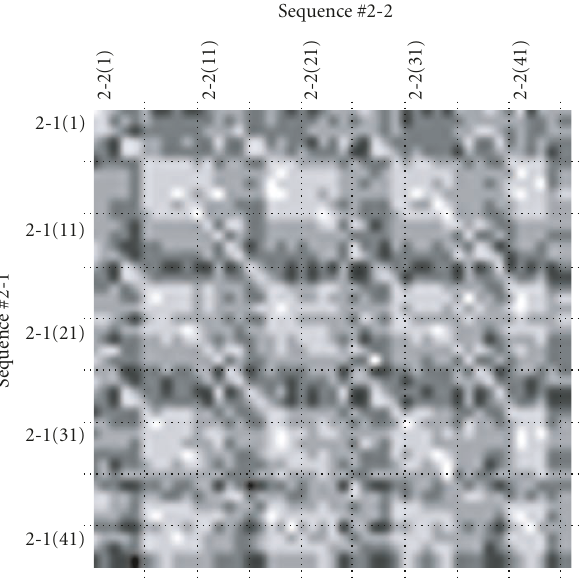
Figure 9: Examples of oversegmentation: (a) when changing pivot- ing foot; (b) when drawing a big circle by arms. Detected overseg- mentation points are shown with circles.